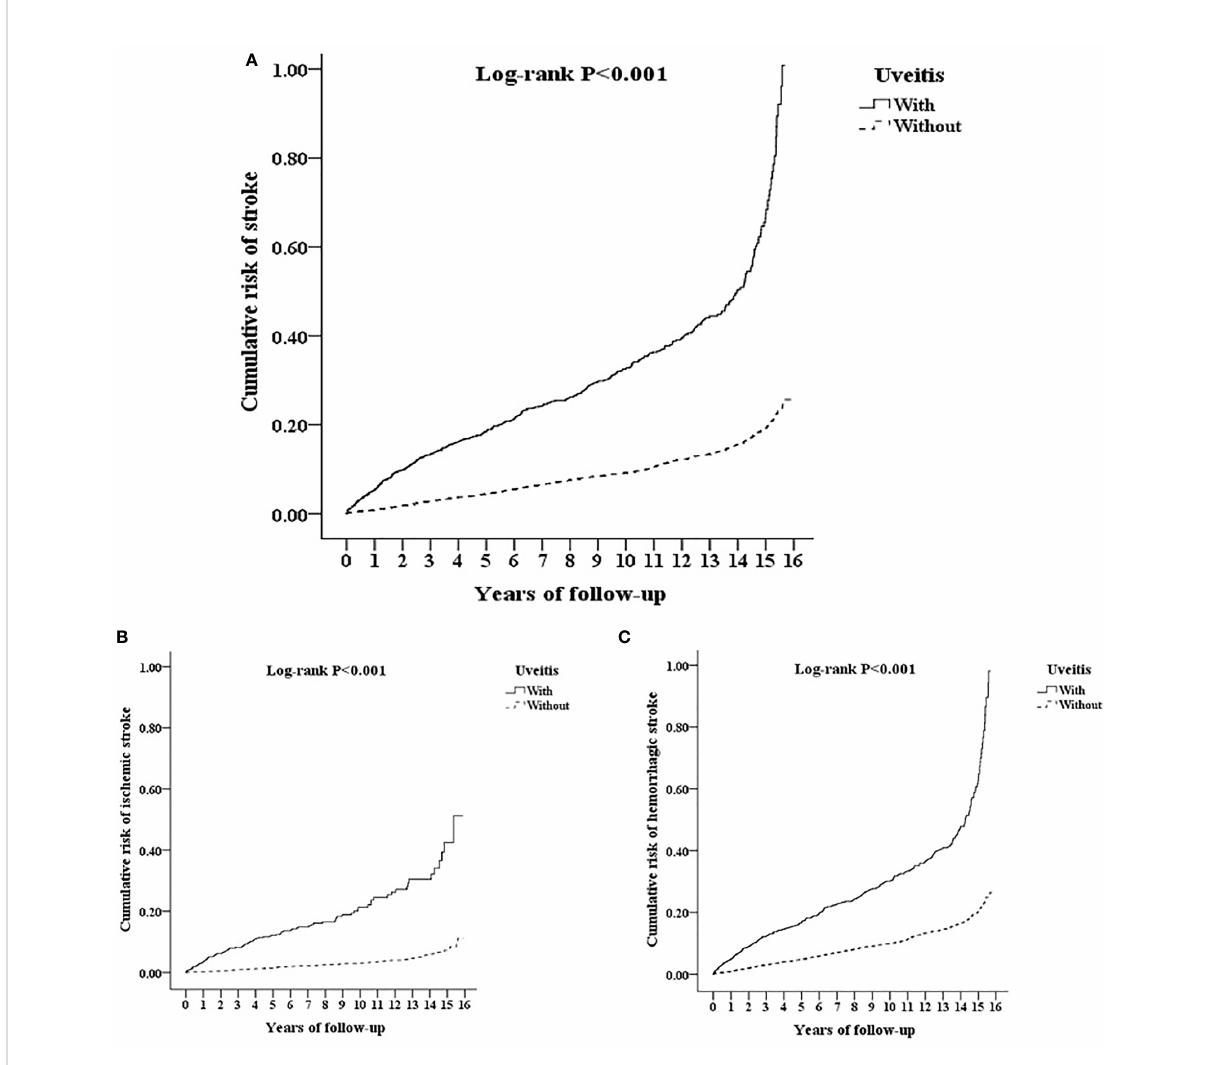
FIGURE 4 Kaplan-Meier for cumulative risk of (A) stroke and subgroups with (B) ischemic stroke and (C) hemorrhagic stroke aged 20 and over strati fi ed by uveitis with log-rank